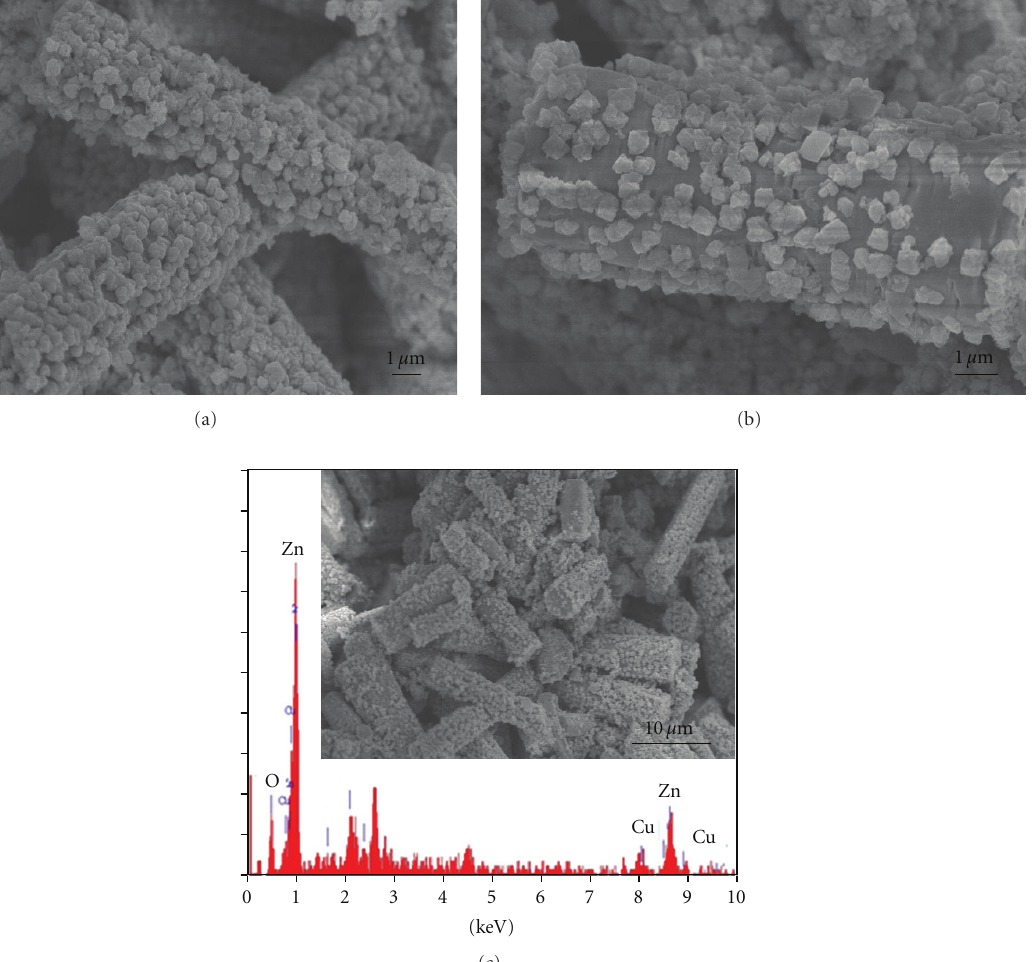
Figure 2: (a)-(b), FESEM images of the hierarchical CuO/ZnO nanomaterials at di ff erent magnifications, (c) the EDS spectrum of the hierarchical CuO/ZnO nanomaterials, insert is an overview SEM